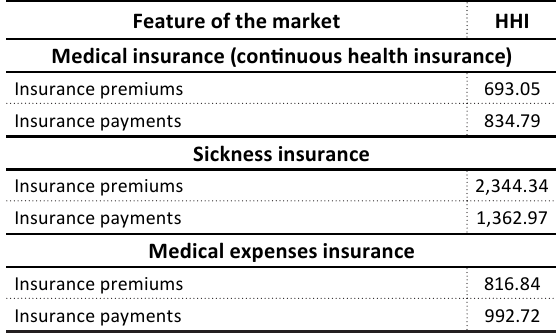
Table 2. Herfindahl-Hirschman Index in the voluntary health insurance market, calculated on the basis of insurance premiums and payments (as of January 1, 2018)